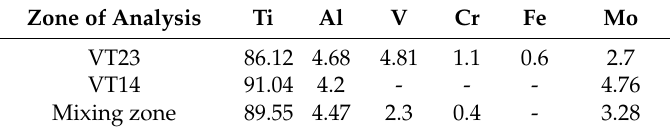
Table 2. Elemental composition of the material adjacent to the interfaces, wt